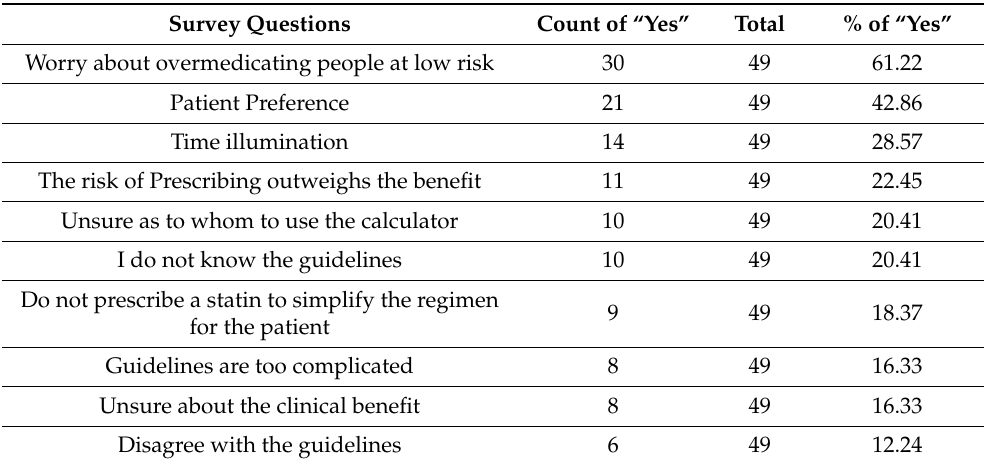
Table 2. Items of the questionnaire were adopted from the poster by Khetan et al. in March 2017. The details of the participants were kept anonymous in order to avoid social desirability bias among the participants of the study. Table 2. Resident survey questionnaire and